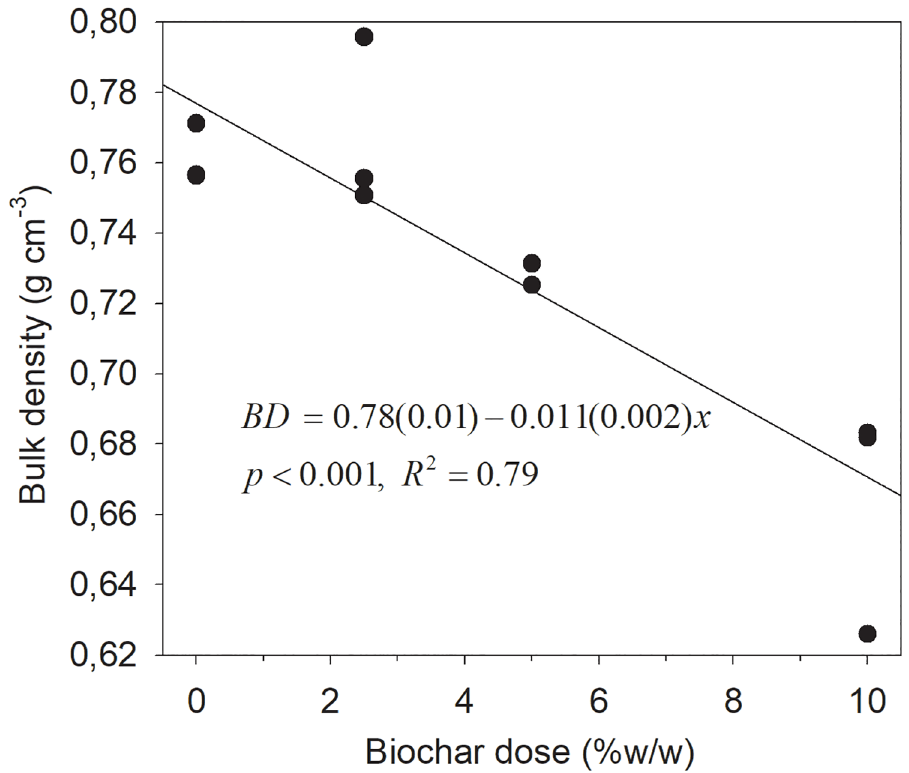
Fig 1. Bulk density of the soil as function of BC dose, n = 3. The soil is from the plough layer of a heavy clay in West Timor,